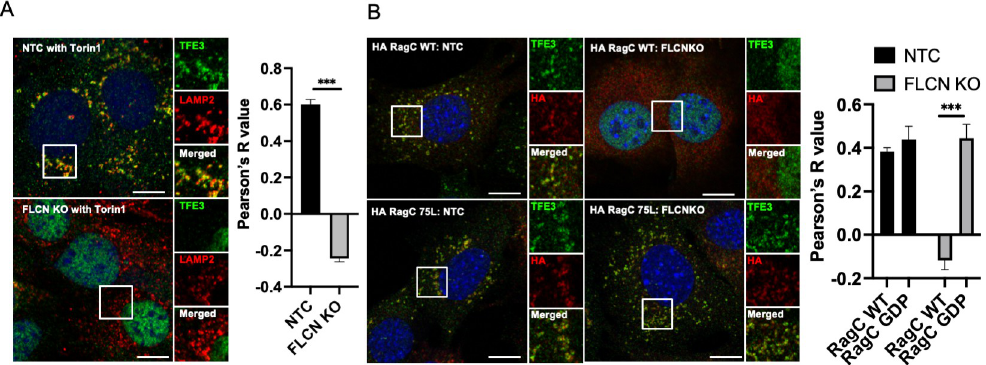
Fig 4. AA stimulation drives transient localization of TFE3 to lysosome via FLCN and RagC. (A) Control C2C12 cells and cells lacking Flcn were maintained for 60 minutes in medium lacking AAs and then returned to complete media in the presence of Torin1 for 15 minutes, followed by immunohistochemistry for subcellular localization of TFE3 and LAMP2, a marker of the lysosome. Right: correlation by Pearson’s R of LAMP2 and TFE3 staining. (B) Cells lacking Flcn were transduced with HA-tagged WT or constitutive active RagA (66L) or RagC (75L), followed by immunohistochemistry as in A. ��� p < 0.001 by Student t test ( n = 3). Scale bar: 10 μ m. The data underlying all the graphs shown in the figure is included in S1 Data. AA, amino acid; FLCN, folliculin; KO, knockout; WT, wild